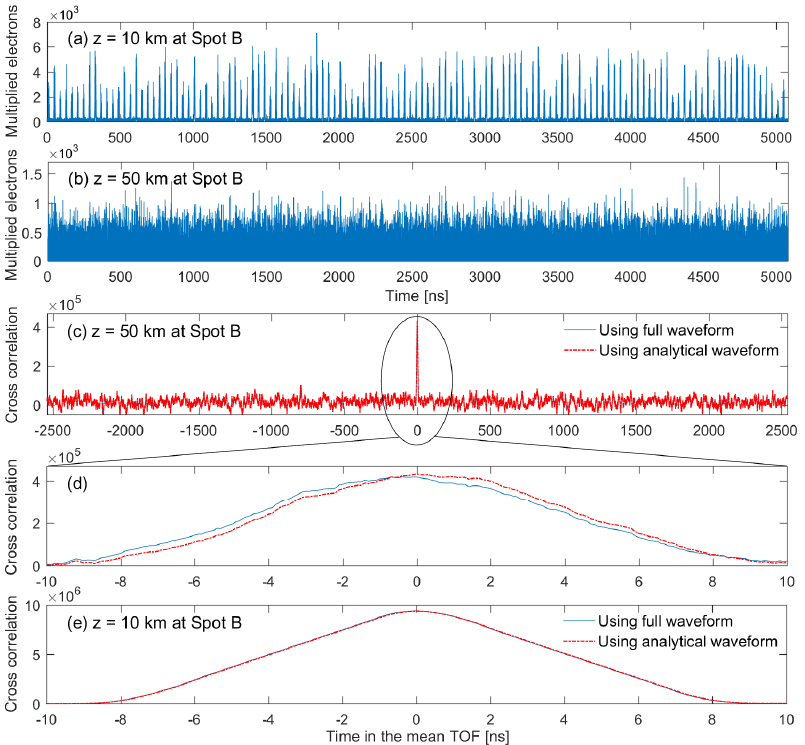
Figure 7. Full waveforms ( a , b ) and cross-correlations ( c – e ) using the full waveform and analytical waveform for spot B. ( d , e ) show the results of cross-correlation over a finer time scale to investigate the characteristics of cross-correlation shape by comparison with Figure 6.